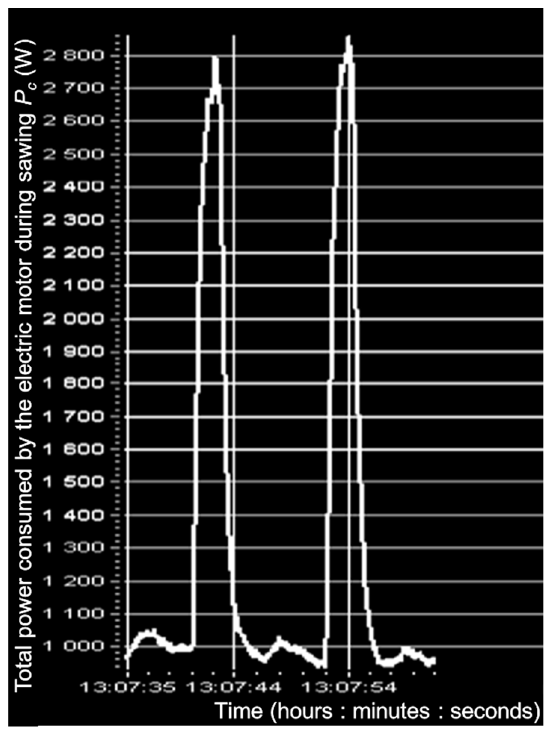
Figure 5. Example of display of measured total power consumed values ( P c ) in the VDS program. Cutting power is calculated following Equation (2). The parameters substituted into the equation are calculated according to Equations (3) and (4):